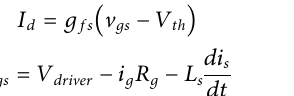
Frontiers in Energy Research |